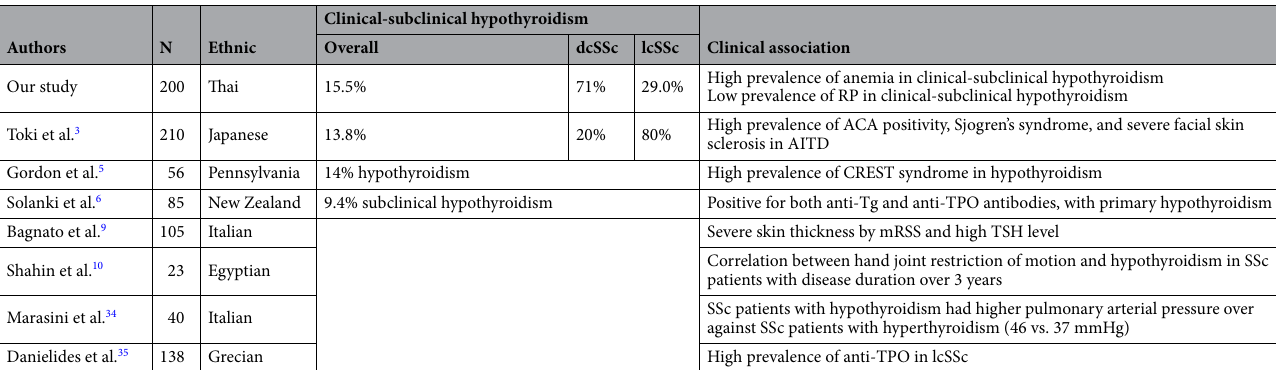
Table 4. Comparison of prevalence and clinical features associated with clinical-subclinical hypothyroidism among SSc patients. dcSSc: diffuse cutaneous systemic sclerosis; lcSSc: limited cutaneous systemic sclerosis; RP: Raynaud’s phenomenon; ACA: Anti-centromere antibody; CREST syndrome: calcinosis, Raynaud’s phenomenon, esophageal dysmotility, sclerodactyly, and telangiectasia. anti-Tg: antithyroglobulin; anti-TPO: anti-thyroid peroxidase